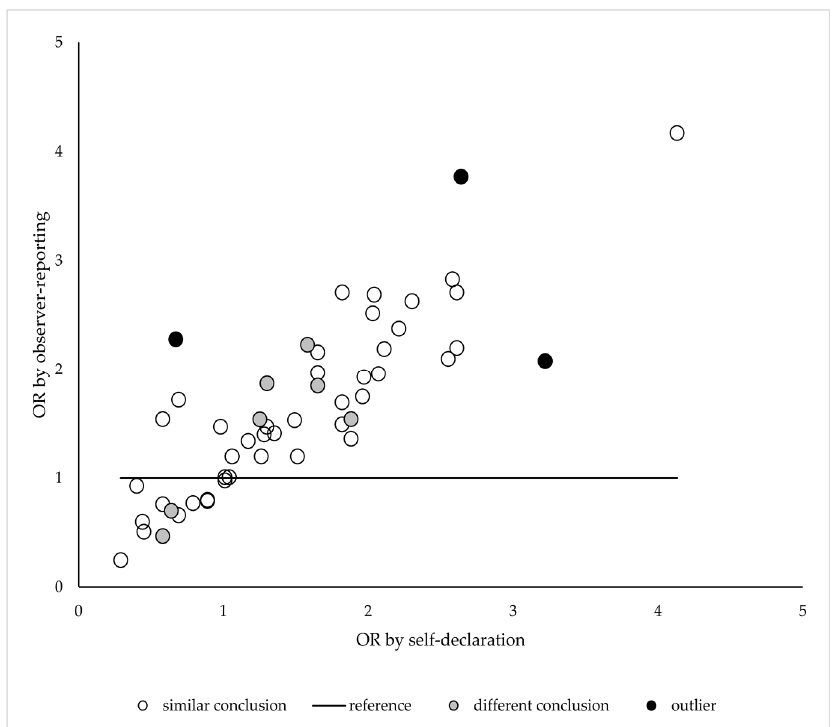
Figure 2. Correlation between socio-economic status adjusted ORs for Roma to non-Roma health status differences from analyses based on self-reported and observer-reported ethnicity assessment by indicators, distinguishing indicators with similar and different statistical conclusions for Roma to non-Roma difference and marking the outlier indicators.